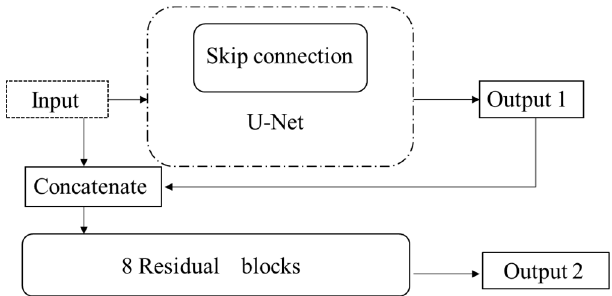
Figure 6. The network architecture in reference [20].